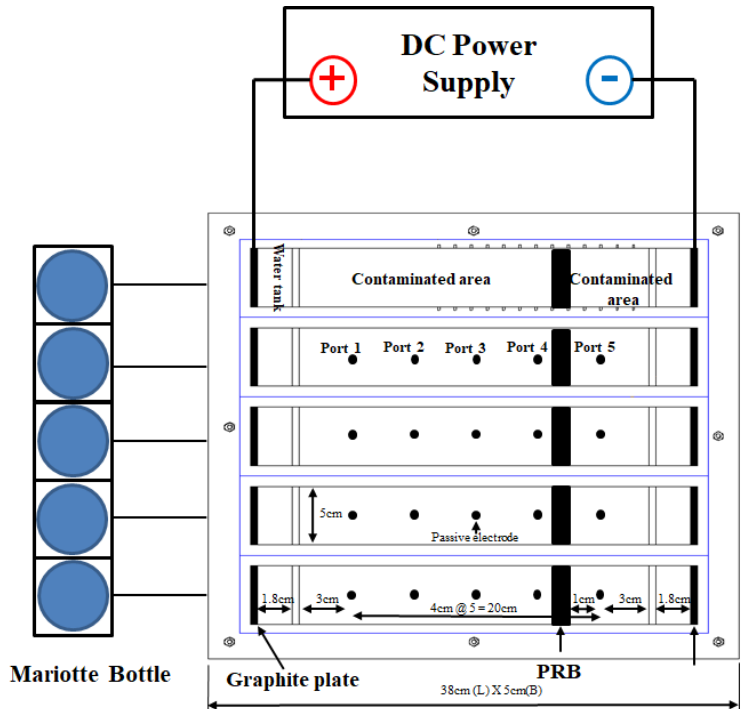
Figure 2. Schematic diagram and dimensions of the EK test device.